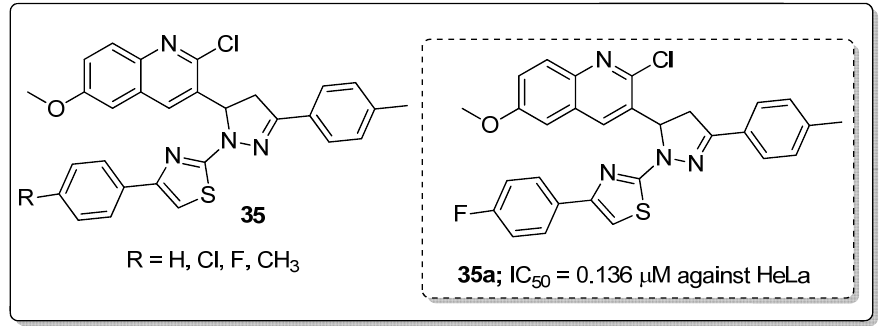
Figure 40. Antiproliferative activity of the most active quinoline ‐ pyrazole ‐ thiazole hybrid 35a .